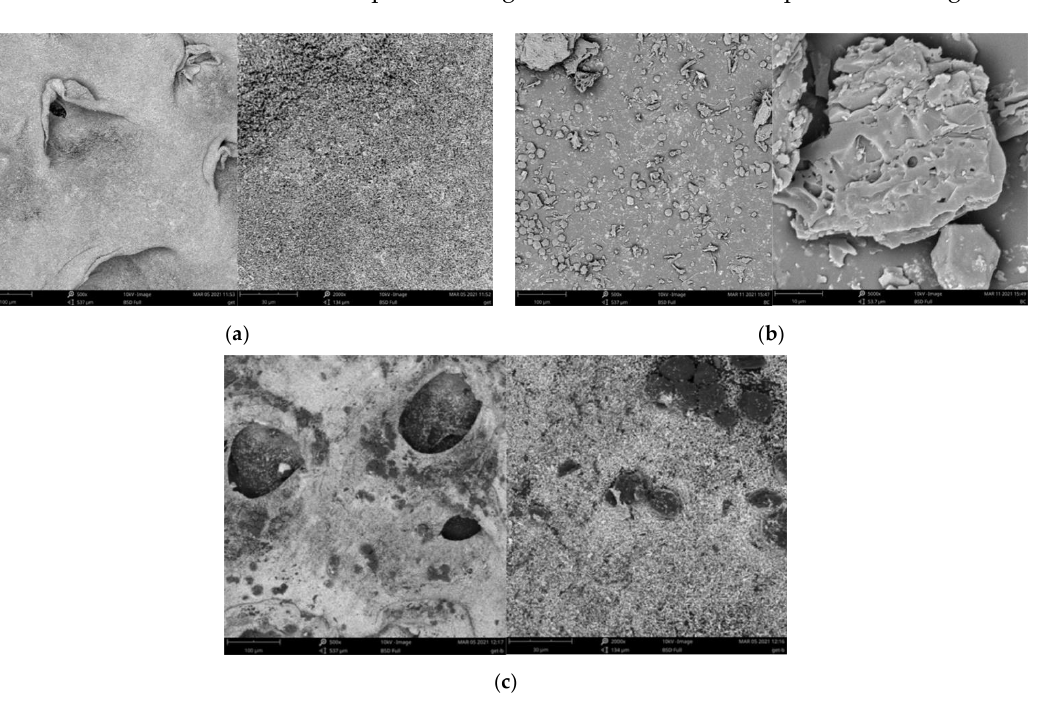
Figure 1. SEM images for goethite ( a ), biochar ( b ) and goethite–biochar mixture ( c ) made with magnification of 500, 2000 or 5000×. Porosity parameters, determined by N 2 adsorption/desorption method, are summa- rized in Table 1. Table 1. Specific surface area, porosity parameters and acidic/basic group content for adsorbents. Parameter